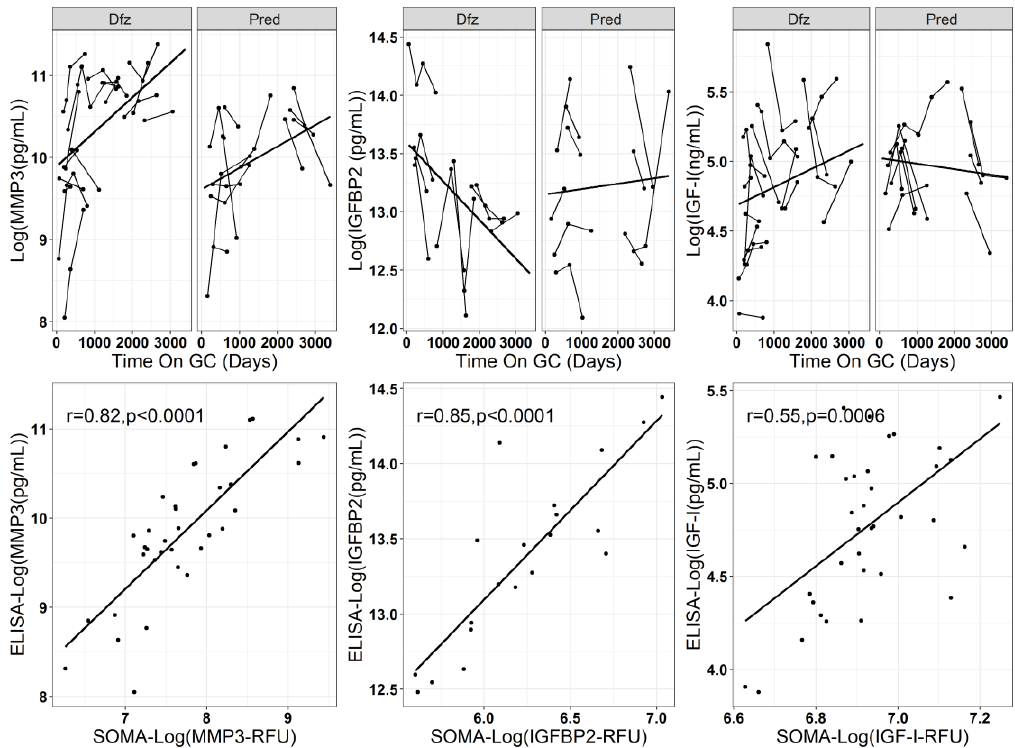
Figure 4. SOMAscan ® signal confirmation using ELISA. Upper panel shows longitudinal trajectories of selected DMD serum protein PD biomarkers from ELISA assays. Lower panel shows correlation plots between SOMA and ELISA data for the samples that overlapped between the screening and confirmation data sets.